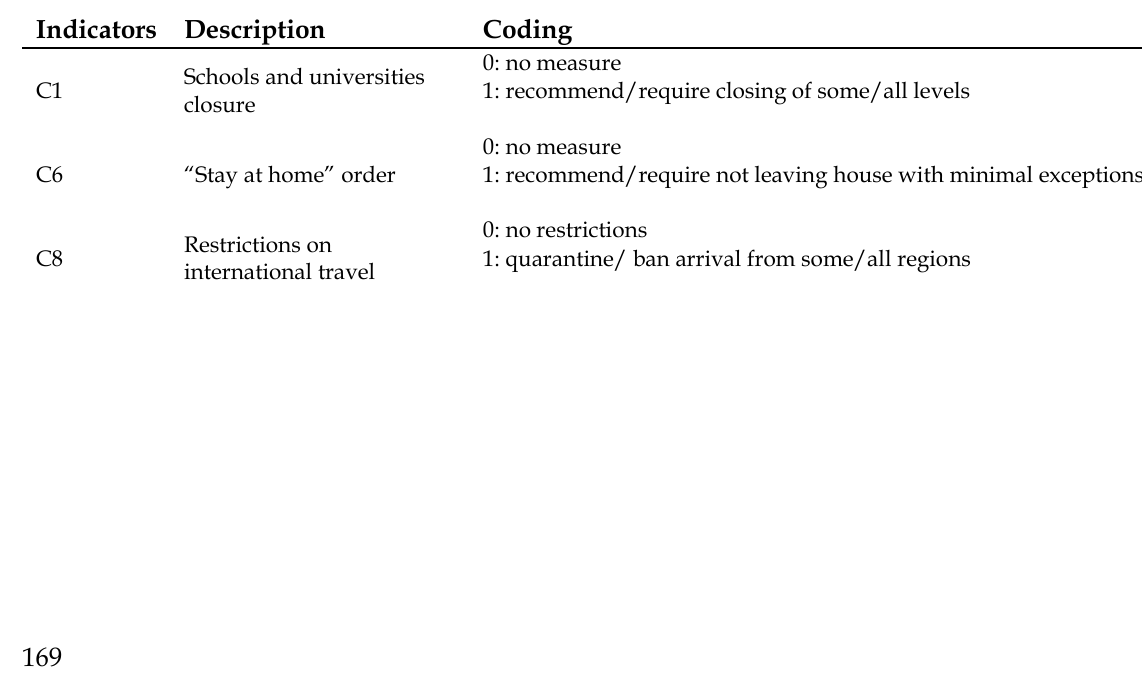
Indicators for containment and closure